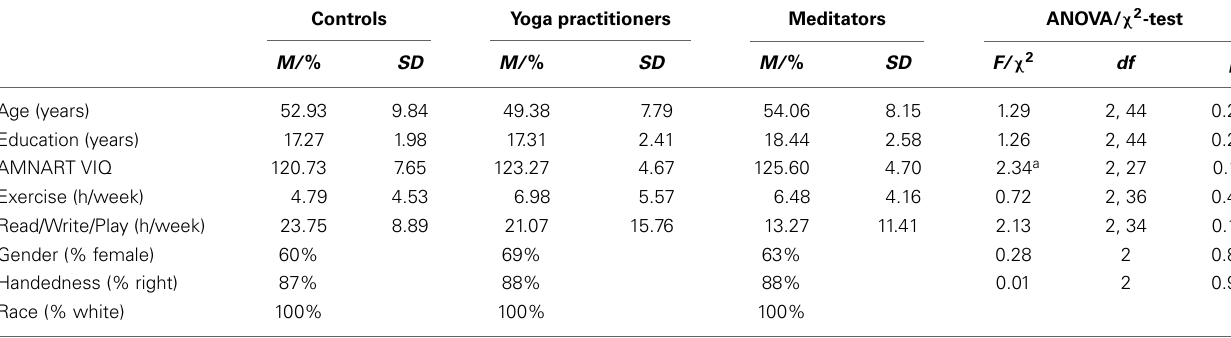
Table 1 | Group comparisons of matching variables and other potential